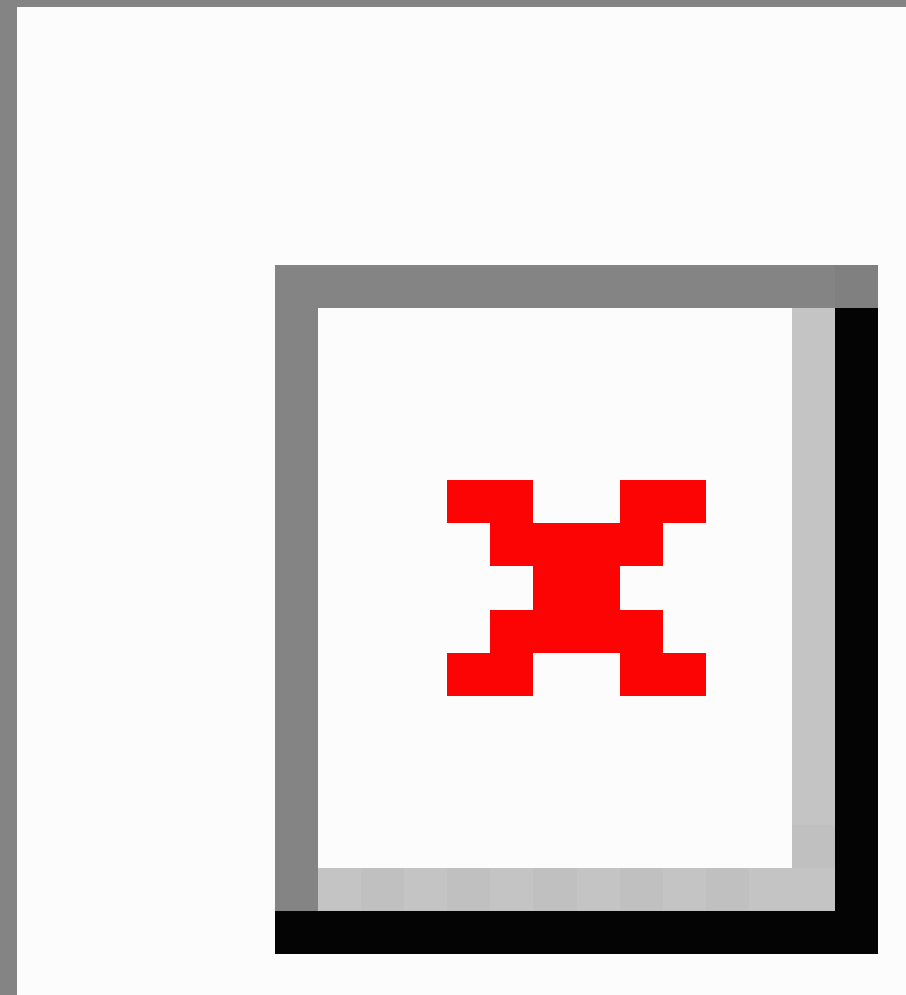
Figure 1. Screenshot of the welcoming page of